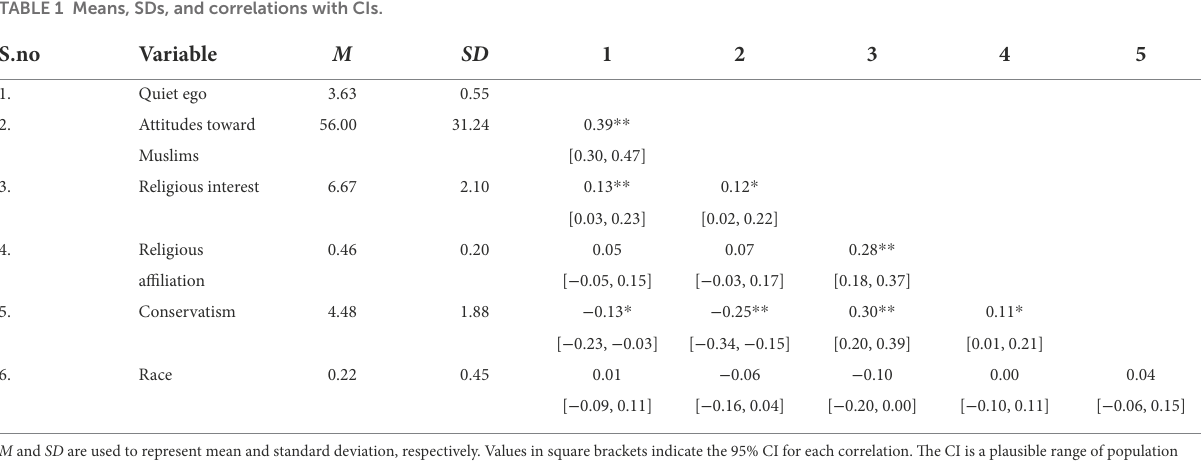
TABLE 1 Means, SDs, and correlations with CIs.